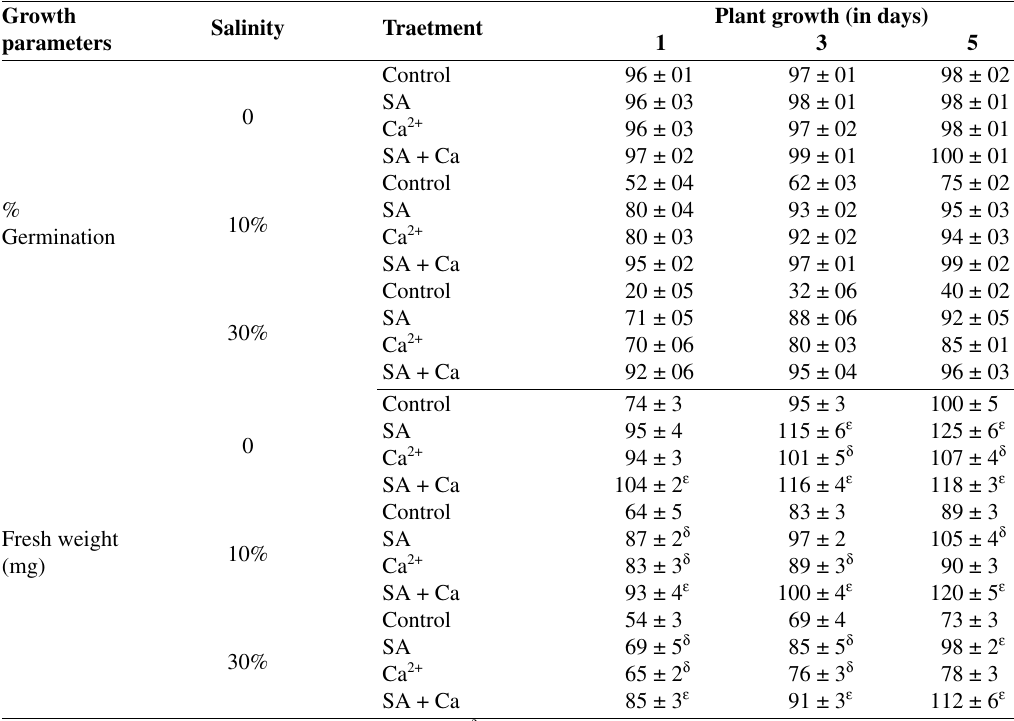
Table 1. Growth parameters:% germination, Fresh weight of wheat four different treatments; control, 0.5 mM SA, 50 mM Ca 2+ , and acombination of SA+Ca under non-saline and 10%-30% salinity stress.